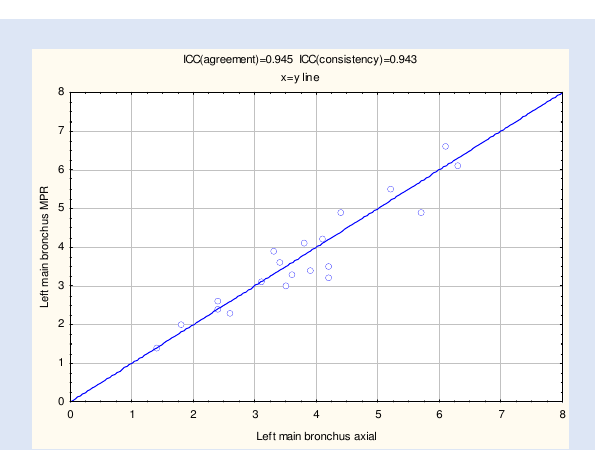
Graph 3. Comparison of axial measurements v. measurements after MPR in the bronchus intermedius.